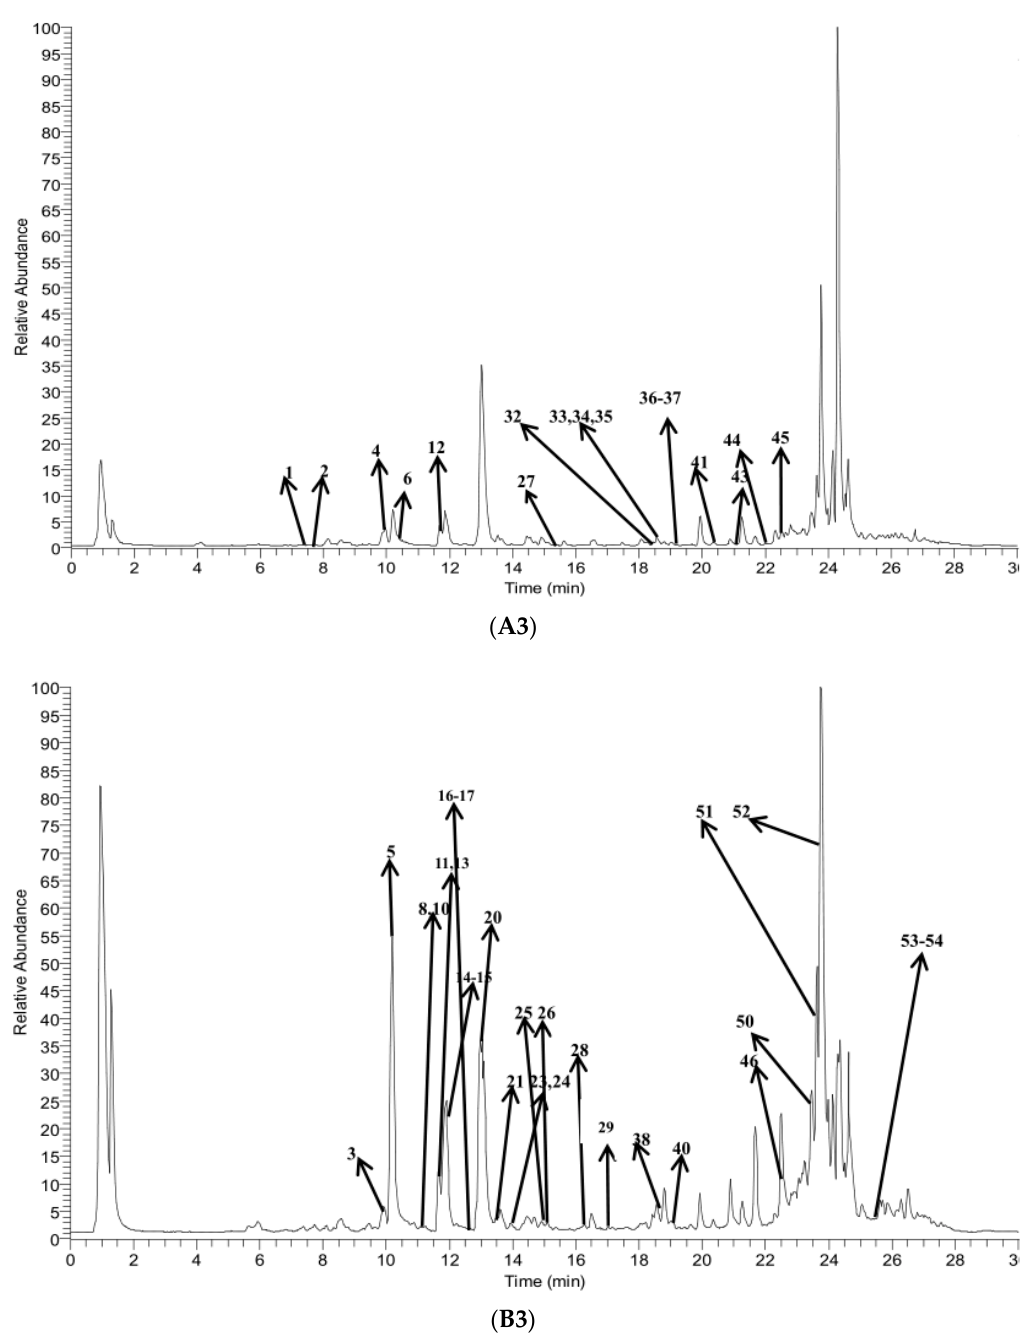
Figure 2. TIC chromatogram of standards, crude and wine-processed Gentiana radix: ( A ) positive ion mode; ( B ) negative ion mode; ( 1 ) standards; ( 2 ) crude Gentiana radix ; ( 3 ) wine-processed Gentiana radix.